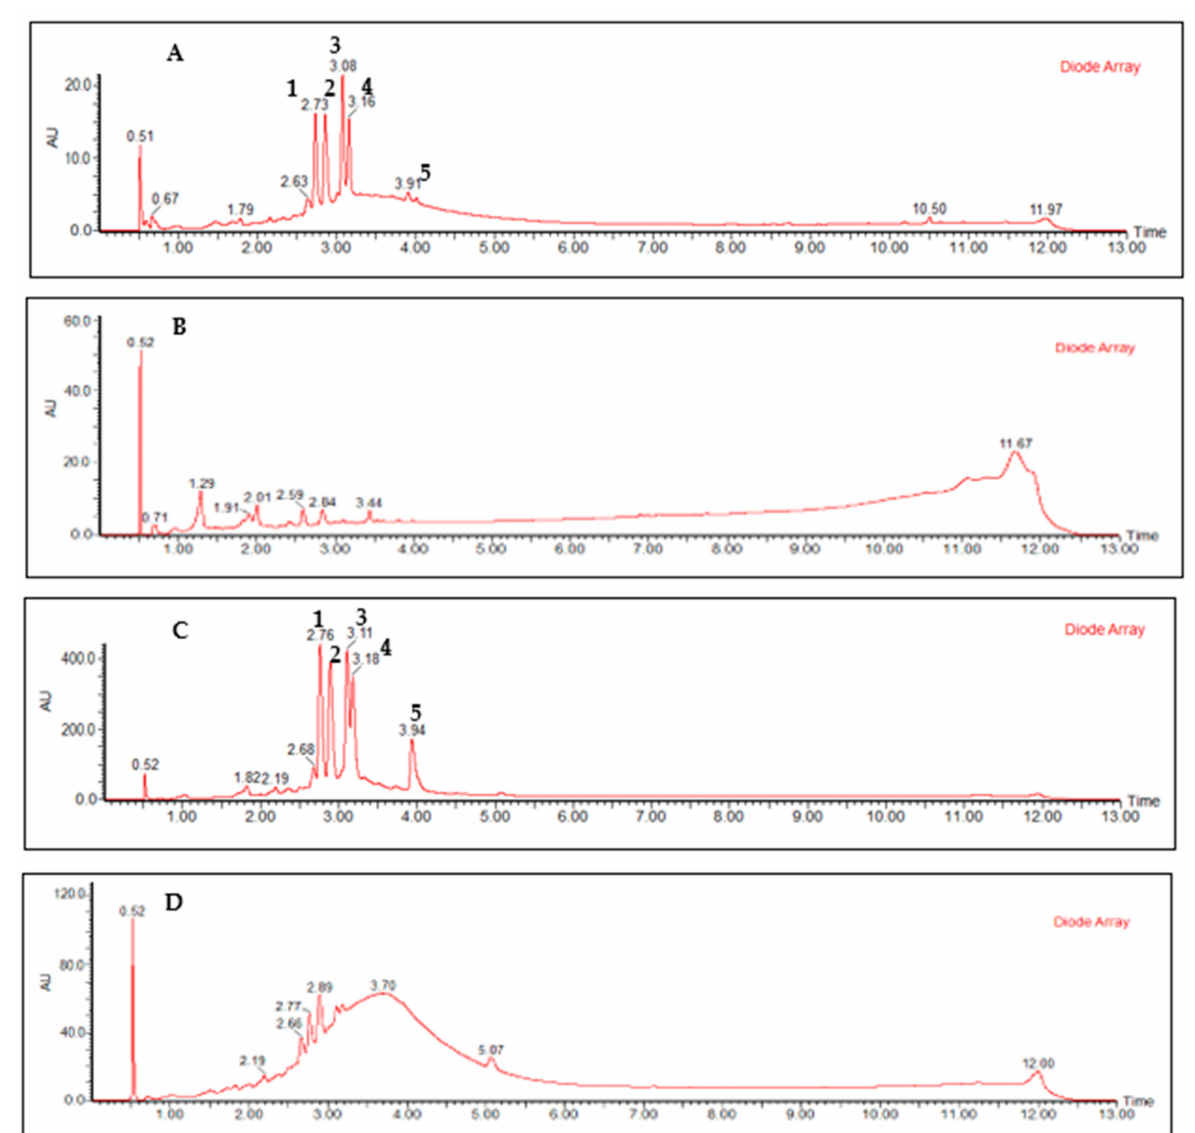
Figure 2. RP-UPLC-DAD profile of ethanolic extract ( A ), dichloromethane fraction ( B ), ethyl acetate fraction ( C ), and aqueous fraction ( D ) of Curatella americana leaves. Conditions: CHS130 100 RP-18 col- umn (1.7 µ m, 50 × 3 mm i.d.). Elution was carried out with a linear gradient of water with 0.1% formic acid and acetonitrile with 0.1% formic acid (from 5% to 95% of acetonitrile with 0.1% formic acid in 11 min), and the UPLC fingerprints were registered on an Acquity (Waters, Milford, Massachusetts, USA) apparatus with a UV-DAD detector (Waters 2996). ( 1 ) Quercetin-3- O -hexosylgallate, ( 2 ) quercetin-3- O -glucoside, ( 3 ) quercetin-3- O -rhamnoside, ( 4 ) quercetin-3- O -arabinoside, and ( 5 )